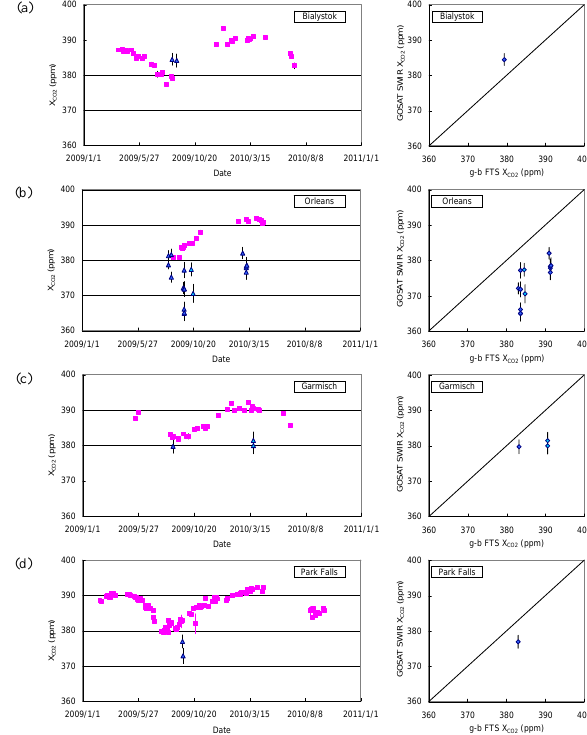
Table 4. As in Table 3 except for X CH